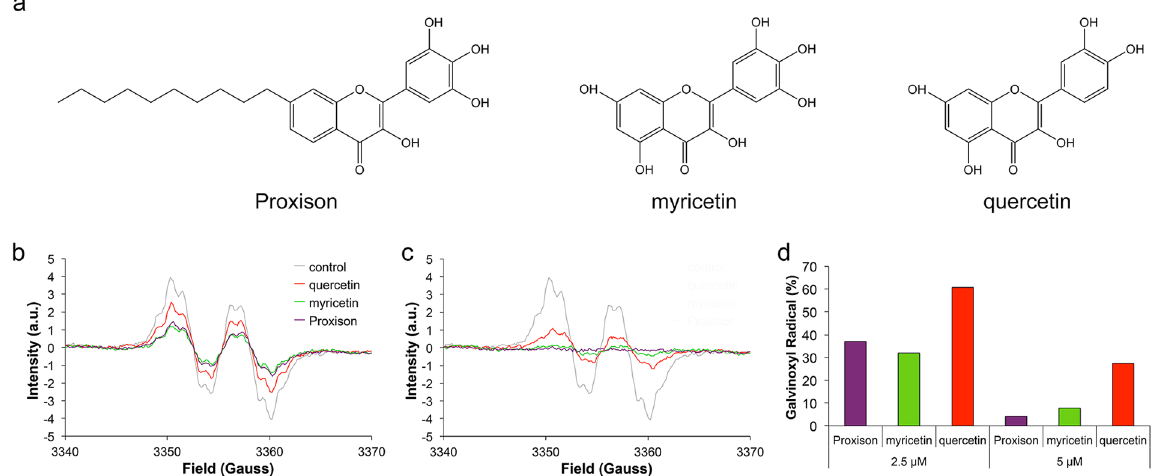
Figure 1. Chemical structures and radical scavenging ability of antioxidants. ( a ) The chemical structures of Proxison, myricetin, and quercetin. ( b , c ) Galvinoxyl EPR spectra in the absence or presence of 2.5 μ M ( b ) or 5 μ M ( c ) antioxidants. ( d ) The percentage of the galvinoxyl radical remaining after incubation with 2.5 μ M or 5 μ M of Proxison, myricetin and